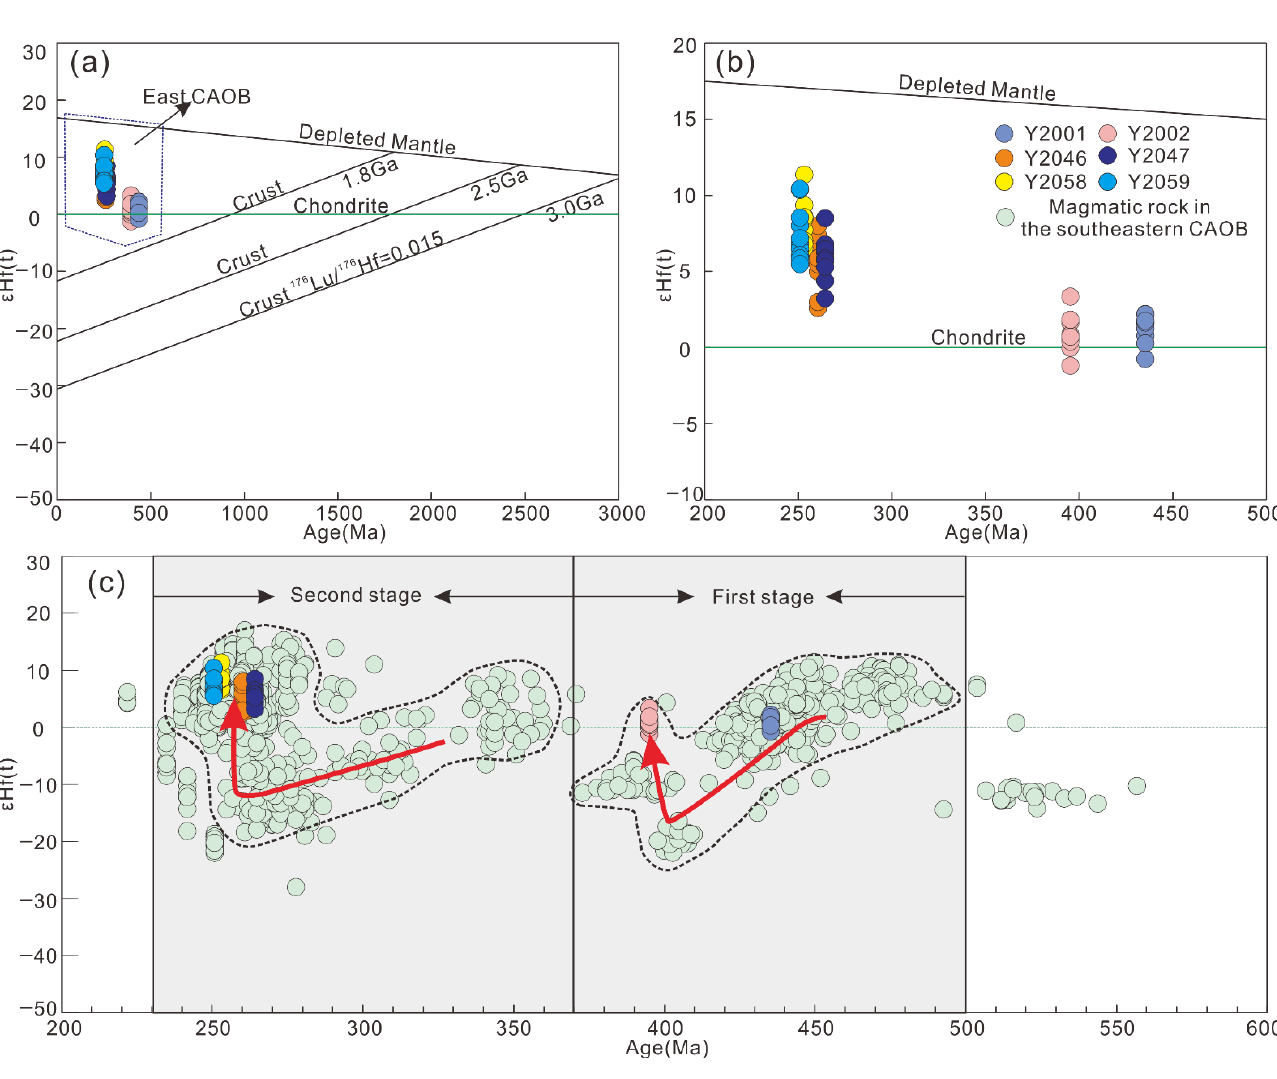
Figure 7. Diagram showing variations of εHf(t) vs. age (Ma) ( a – c ) for Paleozoic to Triassic mag- matic rocks in the southeastern CAOB. Depleted mantle is from Zindler [44]. Hf isotopic data are from [9,12,19,22,23,30,45].